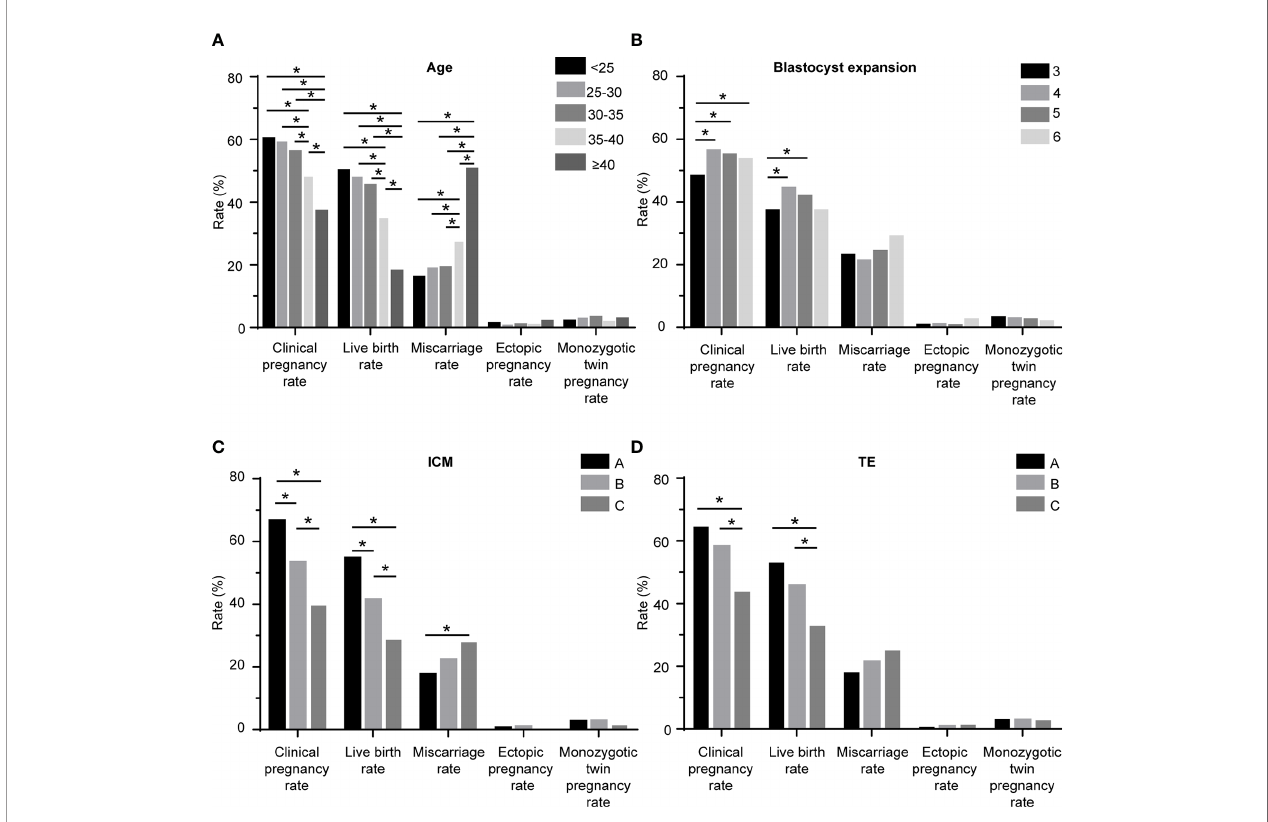
FIGURE 1 | Pregnancy outcomes of the patients. (A) according to the age; (B) according to the blastocyst expansion stage; (C) according to the ICM grade; (D) according to the TE grade. ICM: inner cell mass; TE: trophectoderm; *: signi fi cant different.